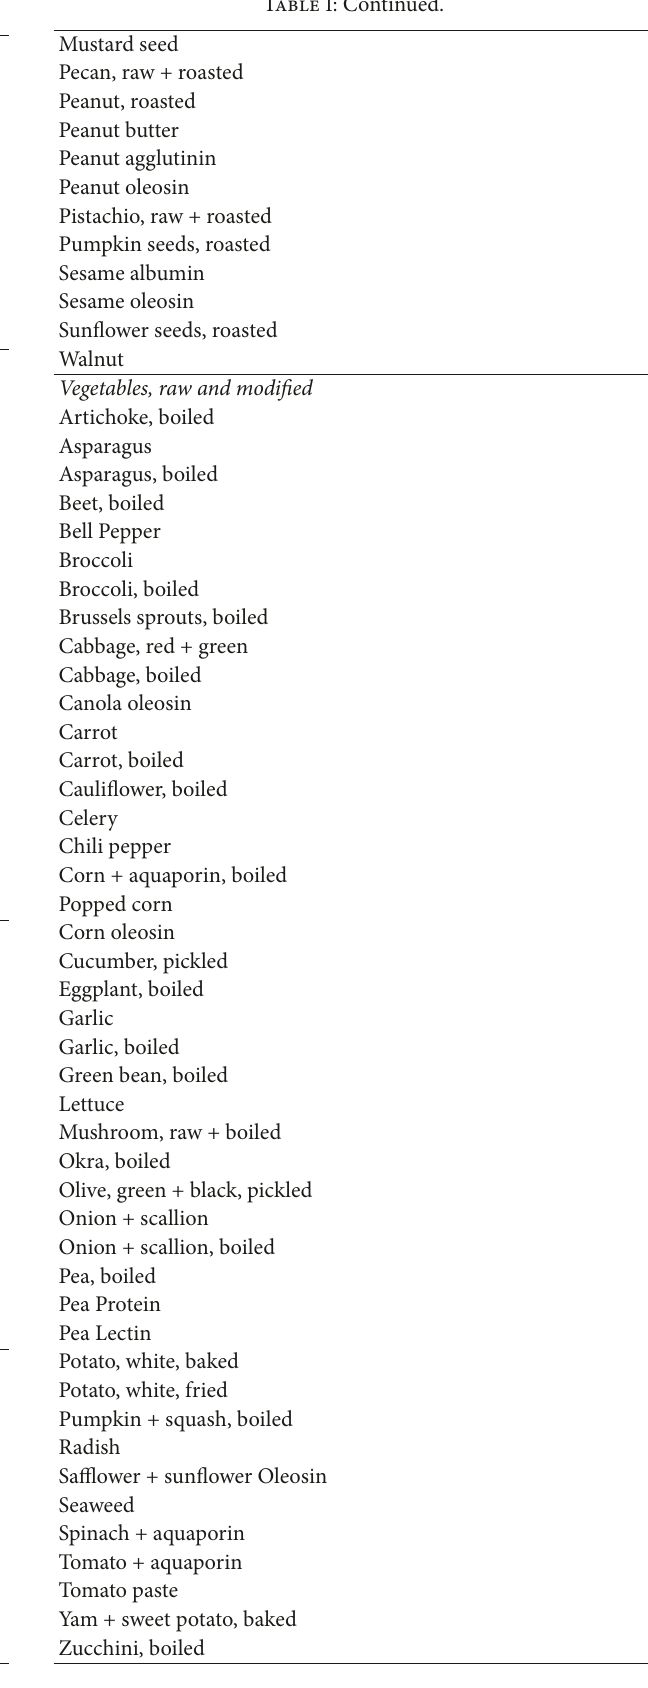
Table 1: Dietary proteins screened for immune